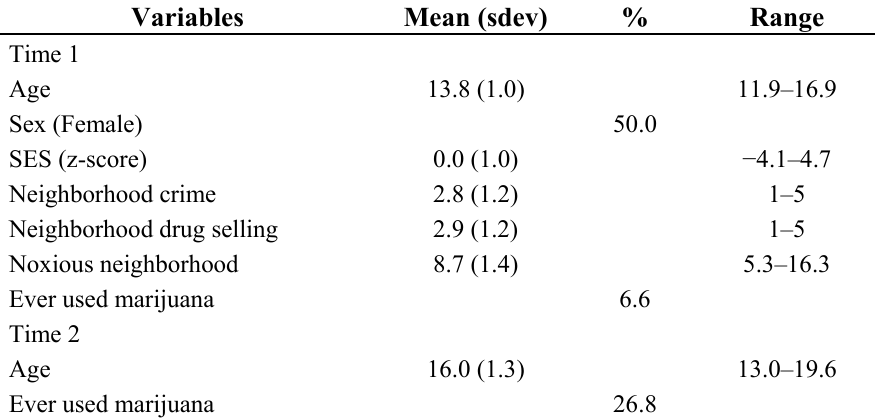
Table 1. Descriptive characteristics of the study participants ( N = 725).